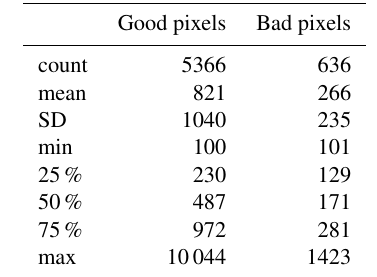
Table A1. Statistics of pixels with and without valid thickness. Numbers represent speed (myr − 1 ) except for the “count” row.